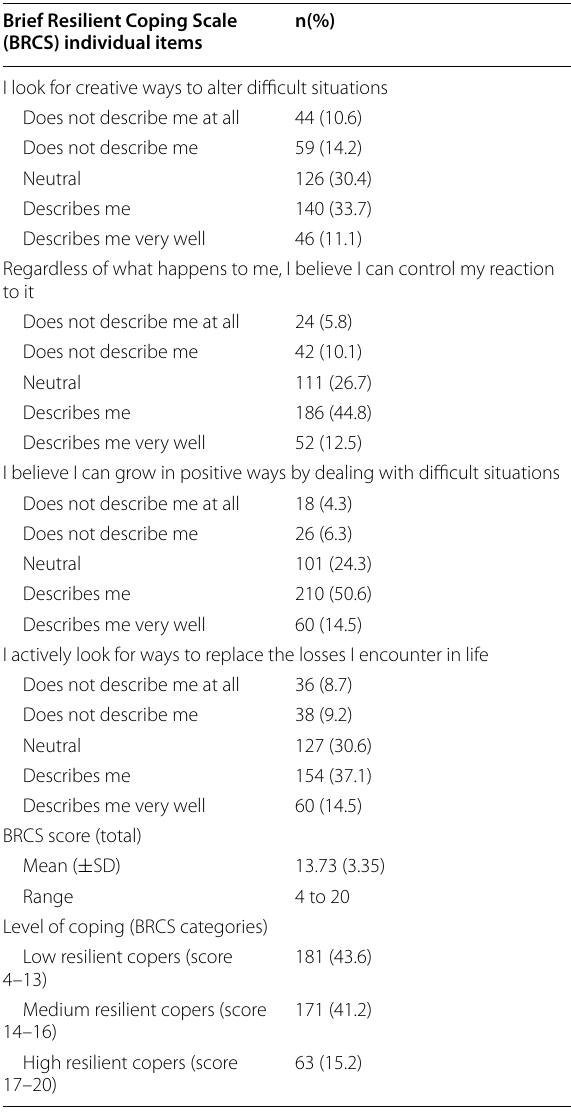
Table 3 Level of fear of COVID-19 among the study